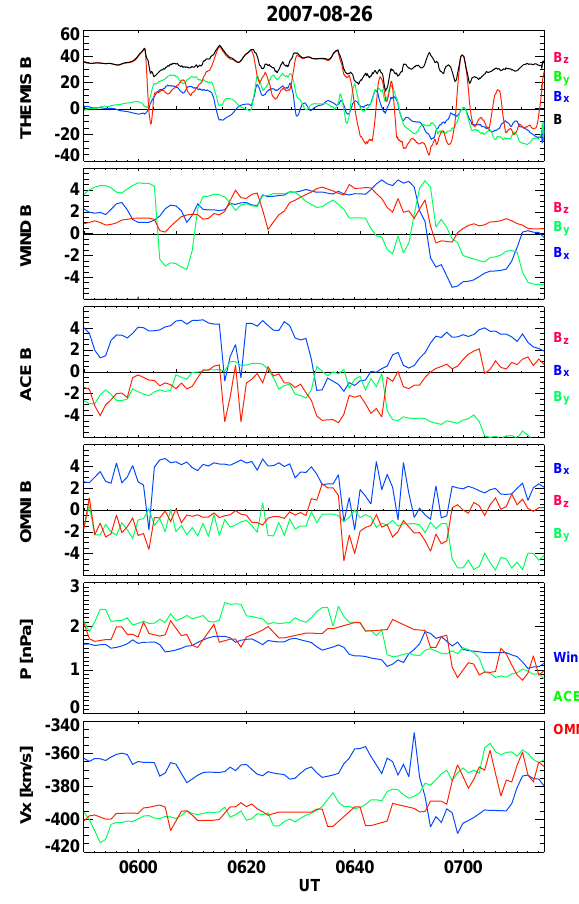
Fig. 3. Measurements of solar wind monitors in the investigated time interval; from top to bottom: the magnetic field from THEMIS B as a reference; Wind, ACE and OMNI, respectively [in nT]; the solar wind dynamic pressure measured by Wind, ACE and OMNI; and the v X components registered by Wind, ACE and OMNI, re-